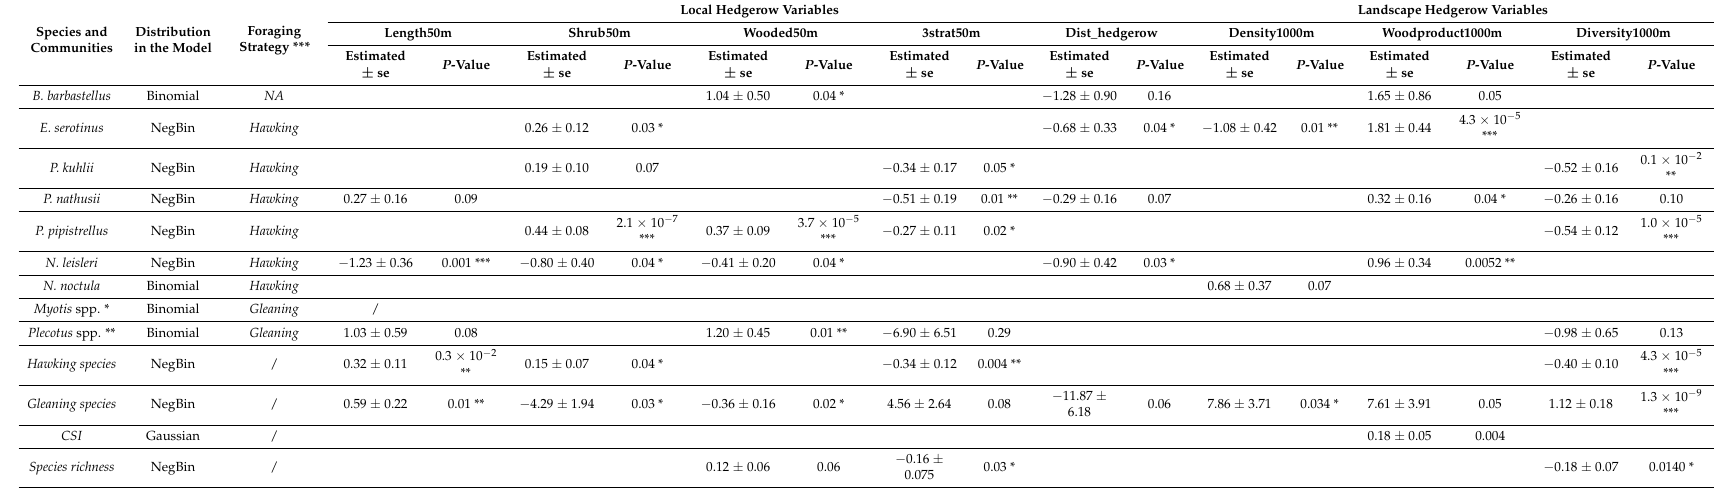
Table 2. Effects of local and landscape variables of hedgerows on bat species and communities’ indices. Co-variables temperature, number of minutes after sunset and spatial autocorrelation are presented in Supplementary Materials